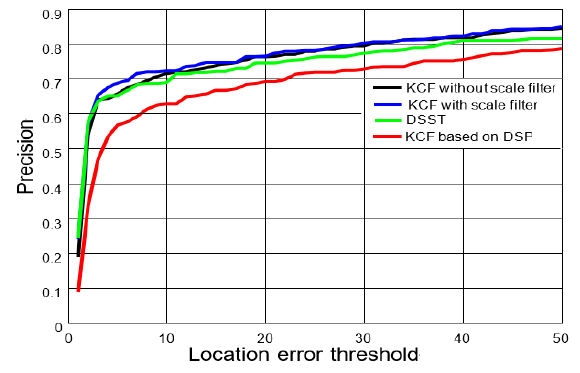
Figure 11. Precision comparison. The x -axis and y -axis denote the distance threshold in pixels and precision (percentages of correctly tracked frames for a range of distance thresholds), respectively.